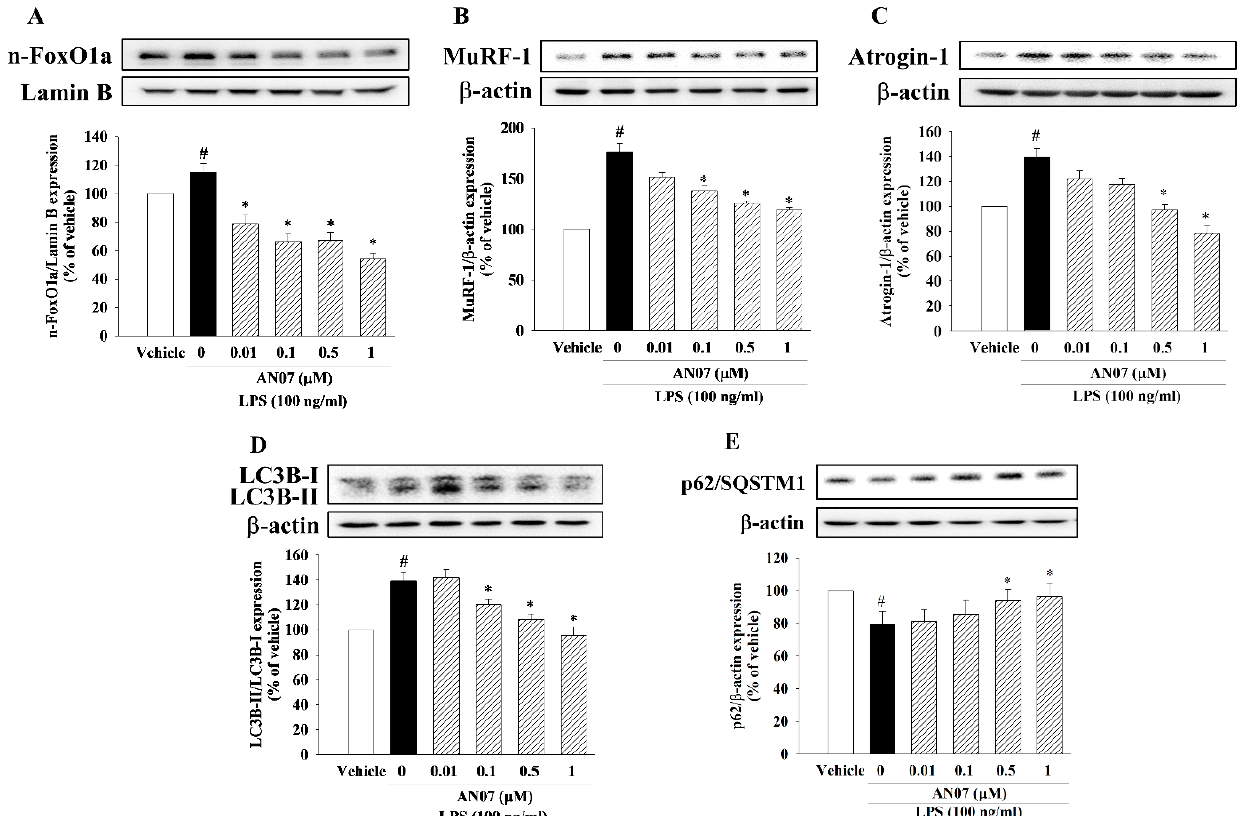
Figure 7. AN07 attenuated LPS-induced protein degradation pathway in C2C12 myotubes. Myotubes were pretreated with AN07 (0.01–1 μ M) for 1 h followed by LPS (100 ng/mL) treatment for 24 h. The protein expressions of ( A ) nuclear FoxO1a, ( B ) MuRF1, ( C ) atrogin-1, ( D ) LC3B-II/LC3B-I, and ( E ) p62/SQSTM1 were measured by Western blotting. Densitometry analyses are presented as the relative ratio of protein/ β -actin or lamin B and are represented as percentages of the control group. Data represent the mean ± SEM from six independent experiments (n = 6). # p < 0.05 vs. control group (vehicle only); * p < 0.05 vs. LPS-treated group according to Kruskal–Wallis test followed by Dunn’s test.